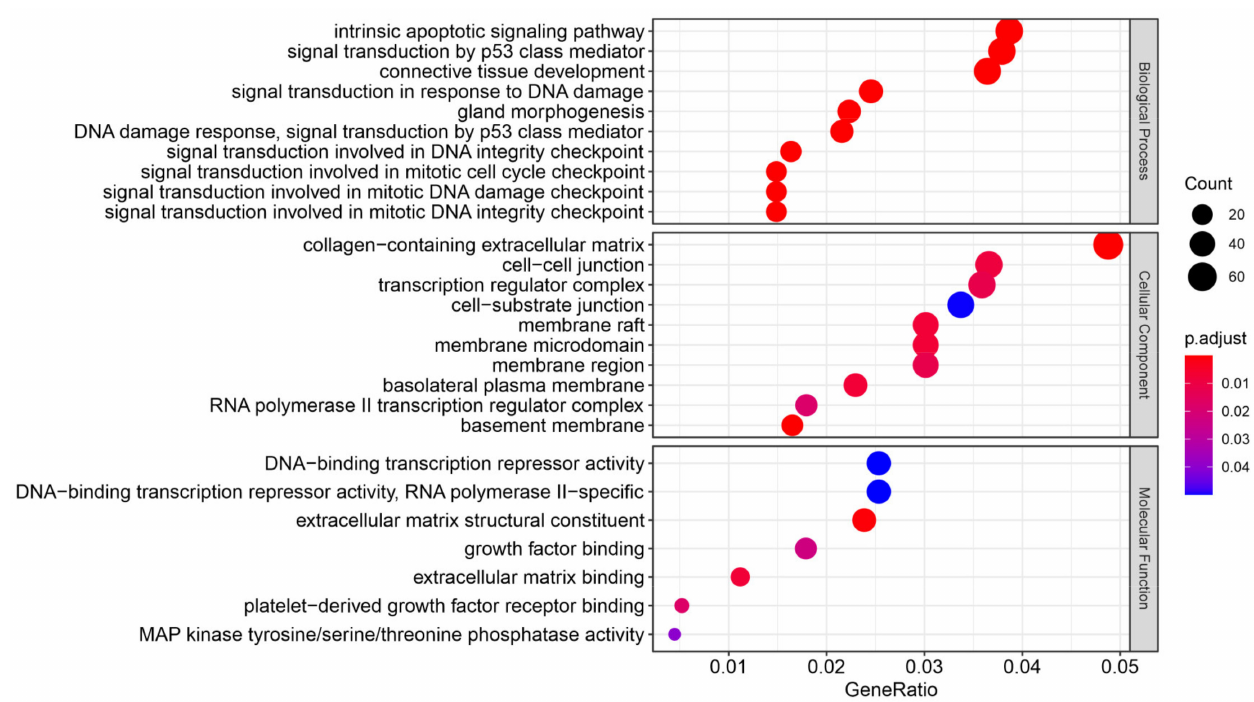
Figure 8. Dot plot of enriched GO terms of differentially expressed genes in cells irradiated in the prostate vs. the sham-irradiated cells. The enriched GO terms belong to three domains: biological process, cellular component, and molecular function. The gene ratio denotes a relative abundance of genes in a GO term. The dot size represents the number of enriched genes in a GO term. The colour represents the adjusted p value. This analysis was based only on the differentially expressed